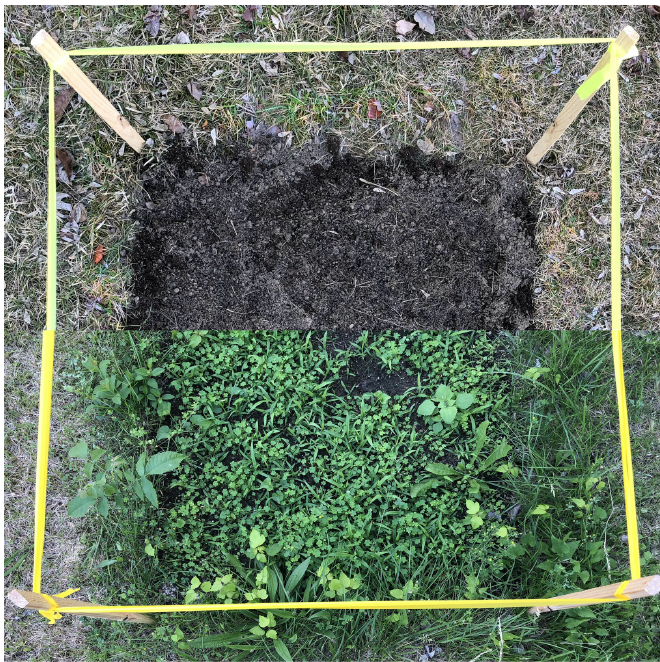
Figure 11: Lawn Lab plot #10 (private yard, South Troy, Ida Street and 5th Avenue), as seen on the day of disturbance and six weeks postdisturbance, March and May 2018. Before (re)disturbance the lawn where the plot was established harbored four plant species. By the time the plot was redomesticated in September 2018, fifteen species had been identified in the one-by-one-meter